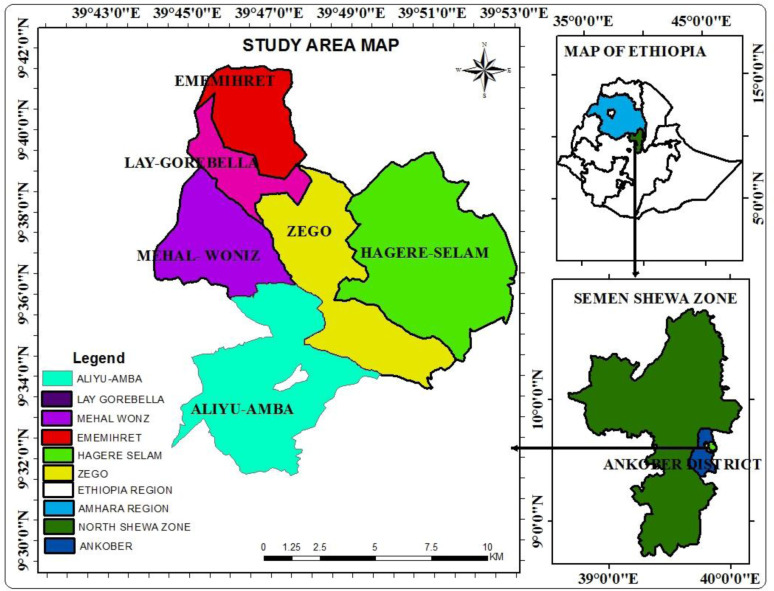
Location of Dinki watershed in the central highlands of Ethiopia [17].